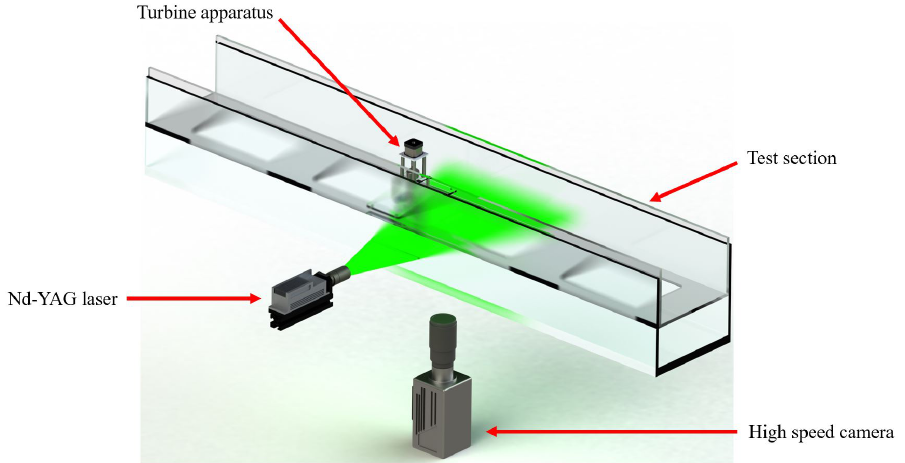
Figure 4. An overview of the monoscopic particle image velocimetry